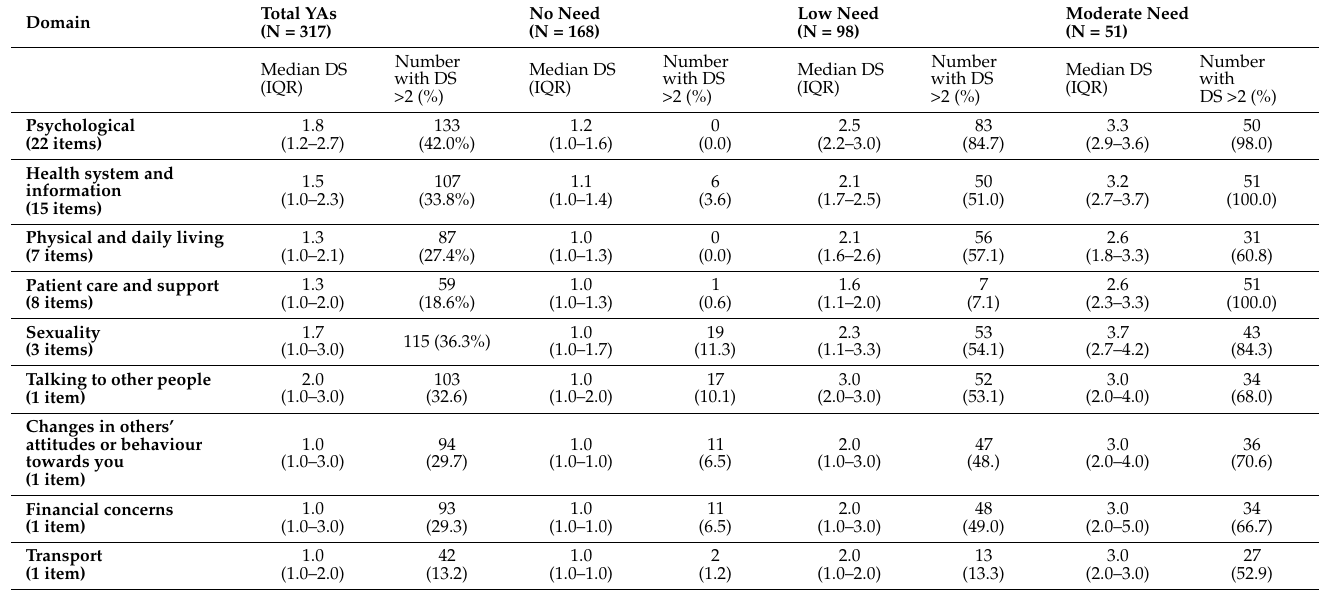
Table 2. Overall domain scores and proportion with unmet need (domain score >2) in each supportive care need domain and single item stratified by predicted latent